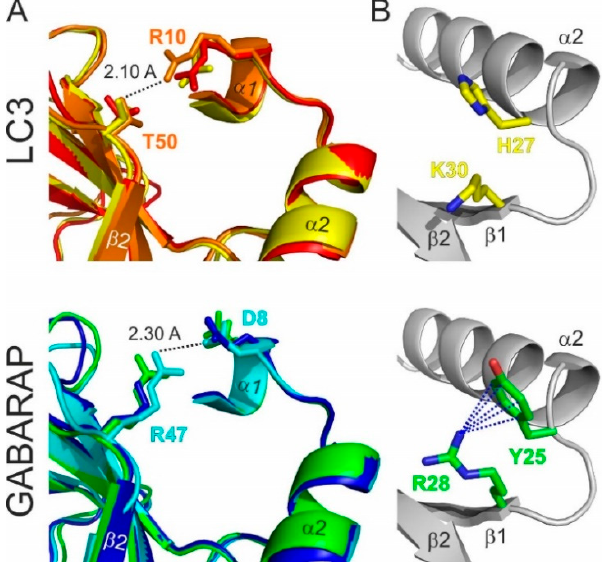
Figure 3. Structural differences between the LC3 and GABARAP proteins. ( A ) Specific structural difference between GABARAP/Atg8 and LC3 protein subtypes. Intramolecular contacts within LC3 (top) and GABARAP (bottom) proteins; color code as in Figure 1D. Involved residues are presented as sticks; the shortest distance is given for specific protein residues (indicated at the plot). ( B ) Orientation of H27 and K30 sidechains in LC3B (top) and corresponding Y25 and R28 sidechains in GABARAPs (bottom). Cation- π interactions (the non-covalent electrostatic interaction between an electron-reach face of aromatic rings and adjacent cations), stabilizing the specific orientation of Y25/R28 sidechains in GABARAPs are shown as dashed lines.